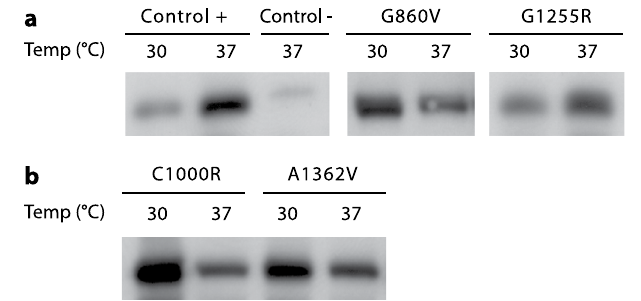
Figure 6. WB of lysates isolated from MD fibroblast cultures cultured at 30 °C and 37 °C, respectively. The MD fibroblasts contain different missense mutations as indicated. Control + is lysate from normal fibroblasts. Control − is lysate from MD fibroblast, containing a big deletion of the ATP7A gene (exon 3–23 deleted). The blots are representative for Western blots of three separate cultures that were harvested and prepared individually for each mutation and control. The Western blots were performed on separate occasions; therefore band intensity cannot be compared between different gels. ( a ) Mutations that lead to low levels of ATP7A in this study. ( b ) Mutations that are similar to or resemble the mutations analysed by Vonk et al . 34 . Gaps indicate that the gel was cut in producing the figure.